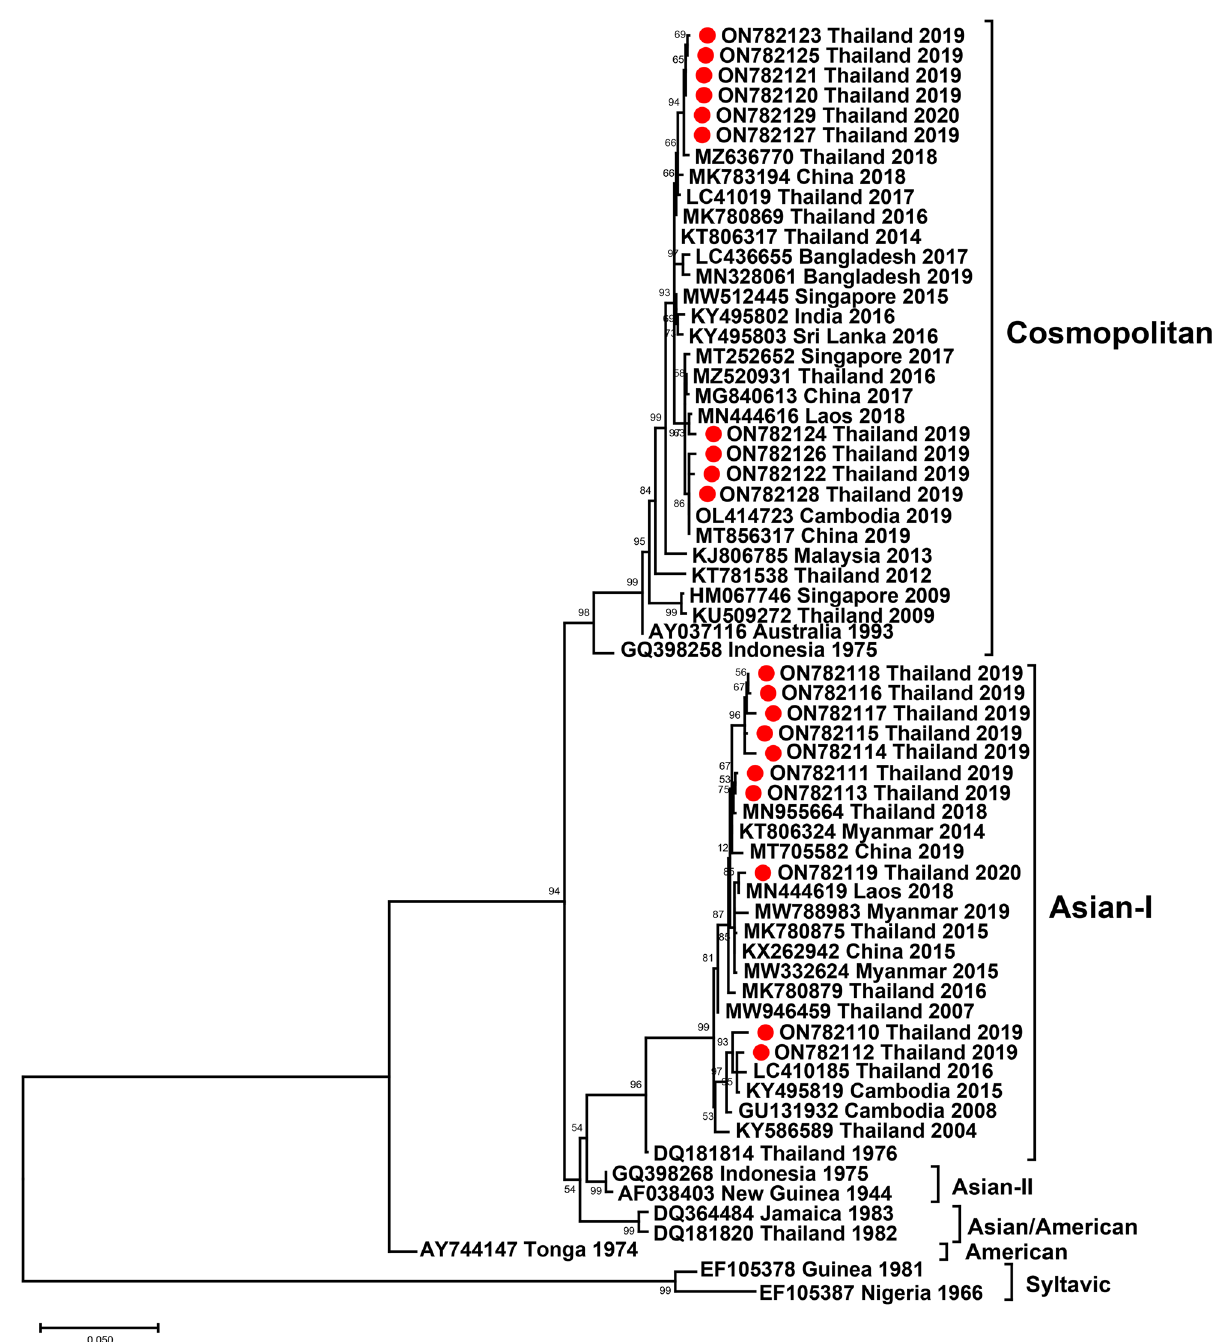
Figure 5. Phylogenetic analysis of DENV-2. The maximum-likelihood tree of DENV-2 was constructed from partial E gene sequences (1090 nucleotides) of DENV-2 Thai strains isolated in this study and strains selected from the GenBank database. The tree was generated using the TIM2 + F + G4 model with 1000 ultrafast bootstrap replicates. Bootstrap values are indicated at branch nodes. Red dots denote DENV Thai strains from this study. Black brackets on the right indicate DENV-2